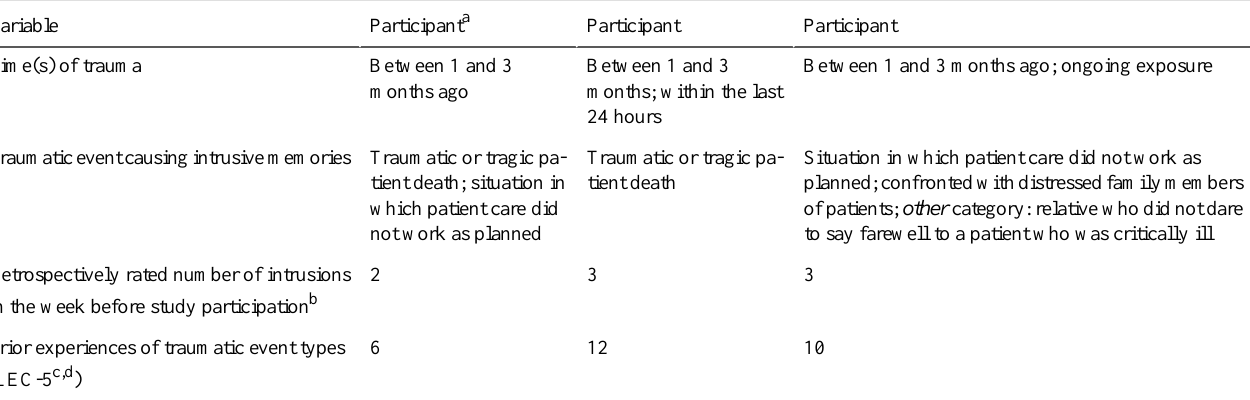
Table 1. Characteristics of the worked-related traumatic events that participants had intrusive memories from and prior experiences of traumatic events reported per